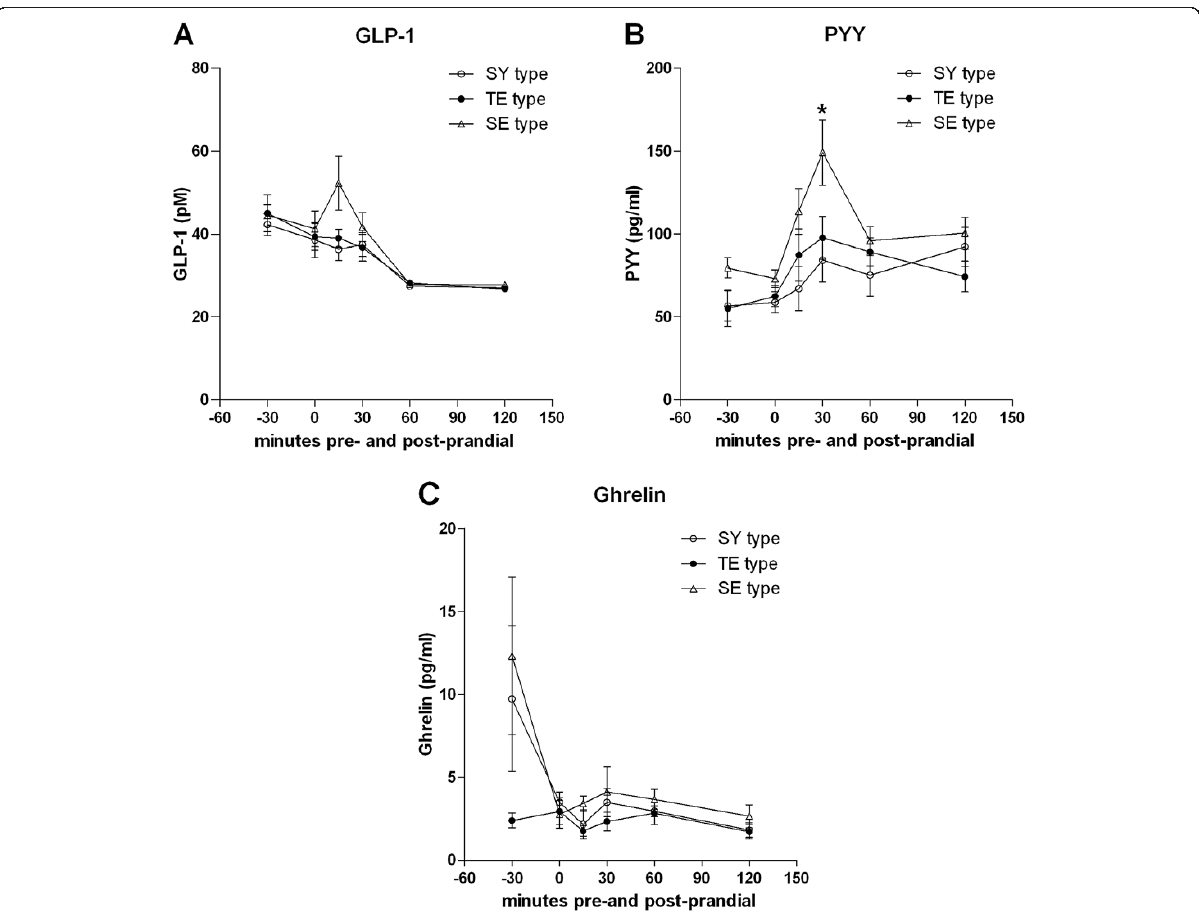
Figure 2 Pre- and post-prandial plasma levels of gut hormones across different Sasang constitutional types. Plotted in each figure are means and standard error of mean (SEM). (A) Glucagon-like peptide (GLP-1) (B) Peptide YY (PYY) (C) Ghrelin. Asterisk (*) denotes significant difference between different Sasang constitutional types at each time-point (p